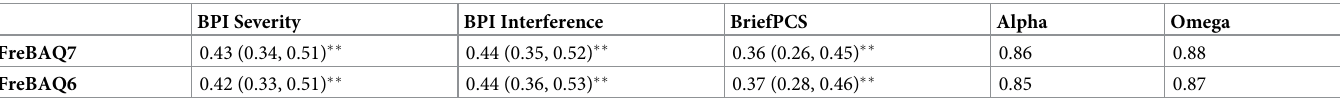
Table 4. Pearson’s correlation coefficients with 95% confidence intervals (columns 2–4), and Cronbach’s alpha (column 5) for the 6- and 7-item versions of the Fre- BAQ-general against the external